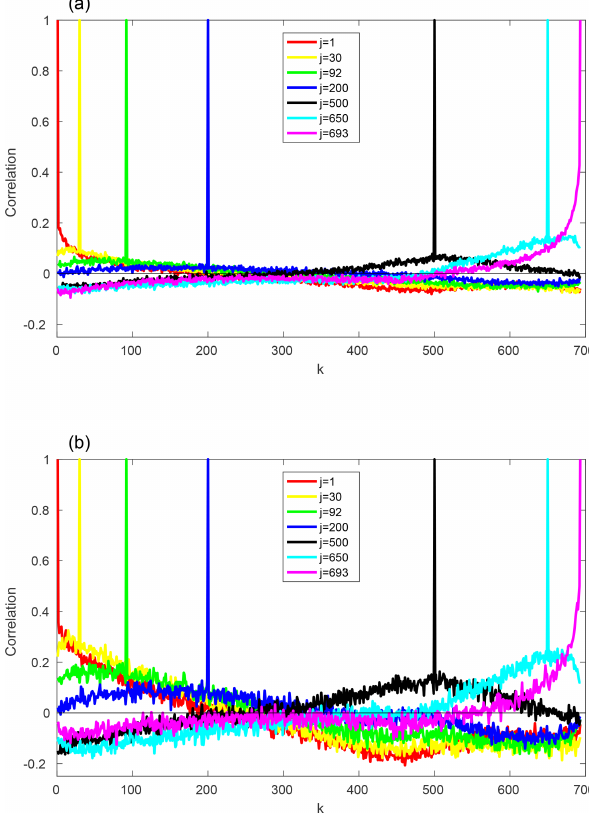
Figure 5. Correlation of the FTLEs (cid:51) (τ) and (b) τ =